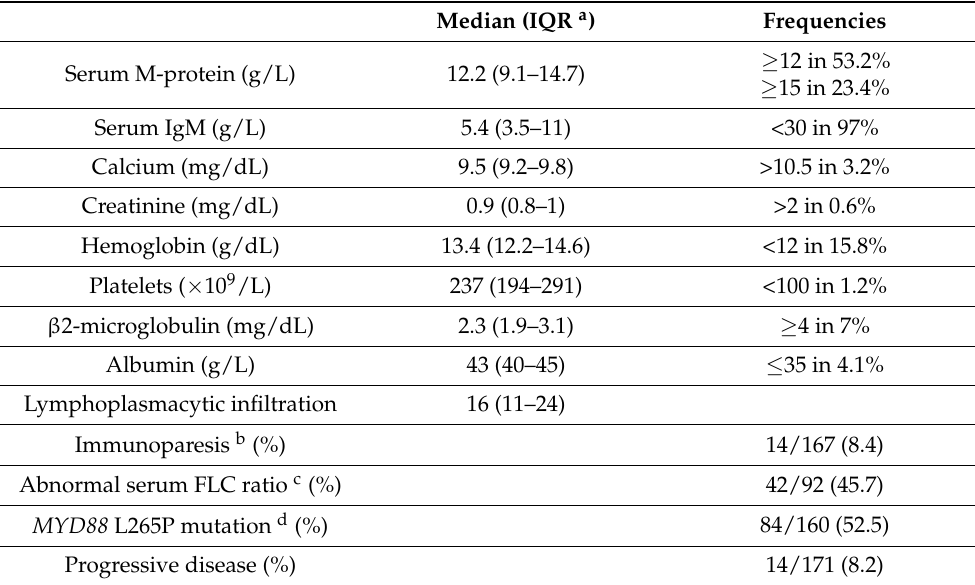
Table 1. Laboratory values in 171 patients with asymptomatic IgM monoclonal gammopathy.